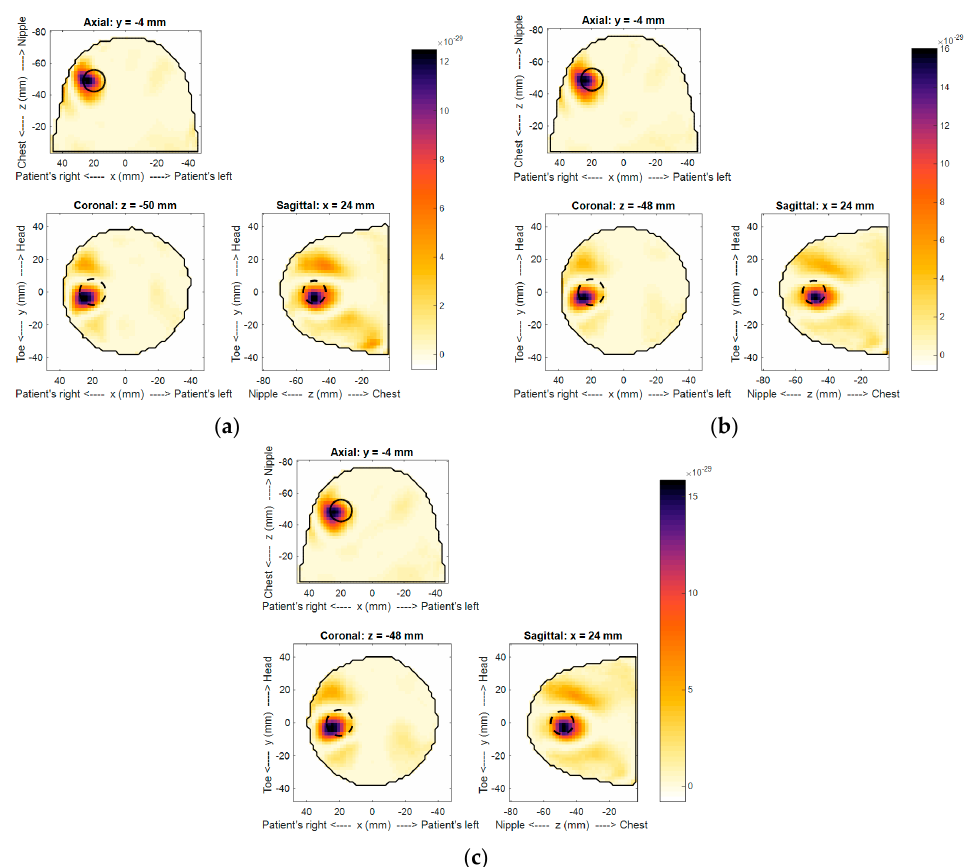
Figure 11. Reconstructed backscatter intensity images of the three consecutive scans ( a – c ) of the breast phantom. Dashed circles represent the location of the 16 mm target. Note that the color bar is unitless.